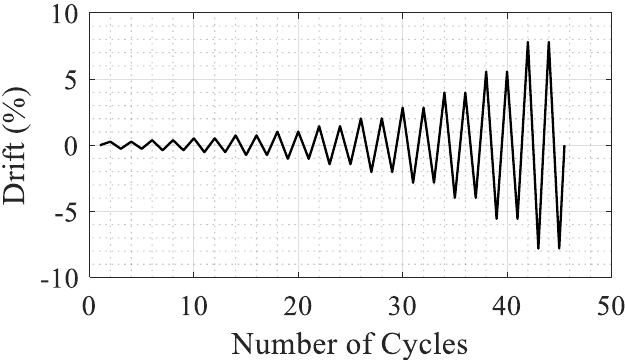
Figure 5. Cyclic loading protocol used in the experiment (maximum drift is 7.69%).